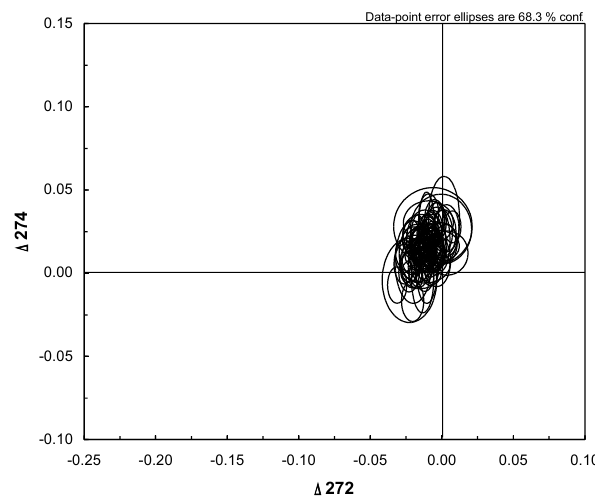
Figure 2. (cid:49) 272 vs. (cid:49) 274 plots for zircon analyses under standard operating conditions for SHRIMP geochronology.